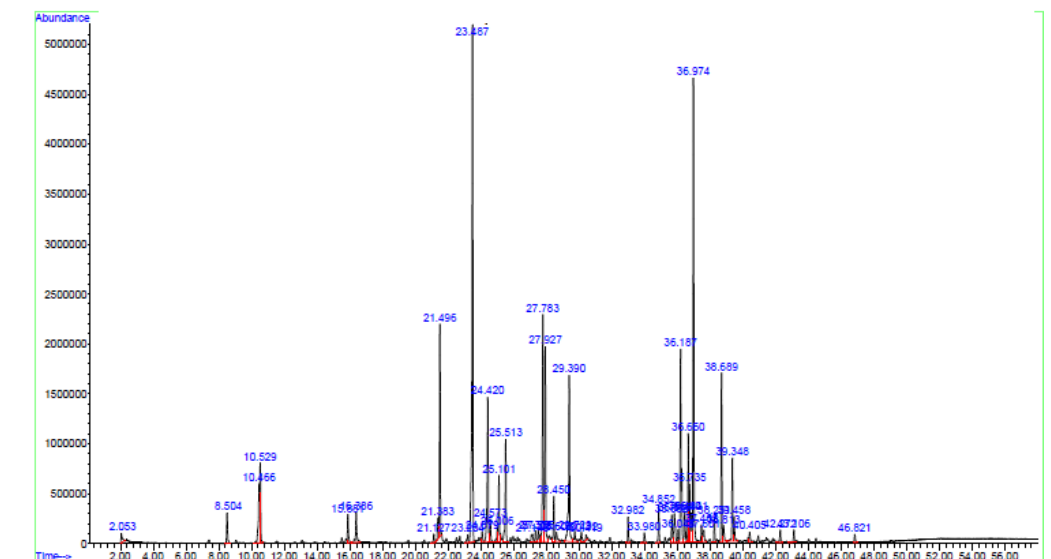
Figure 4. Gas chromatogram of the essential oil of ‘Çakmar’ white